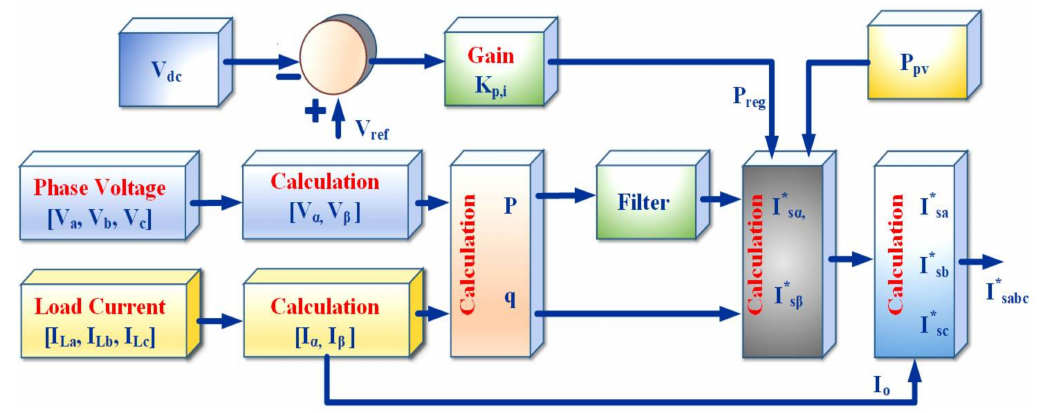
Figure 5. Shunt Active Power Filter compensation-based control strategy ( P-Q